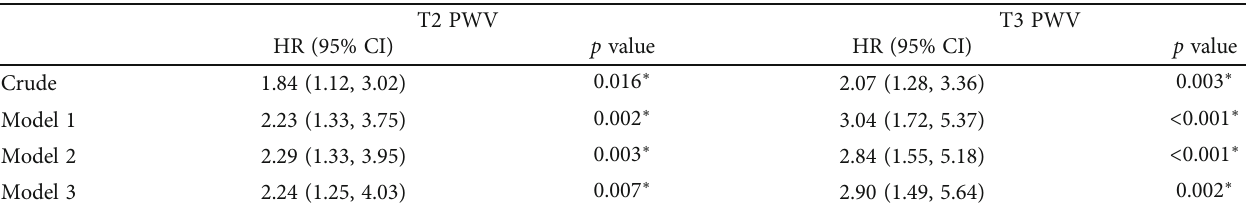
Figure 2: The relationships between baPWV and new onset/progression of DR: (a) boxplots showing distributions of baPWV between the group without and with new onset/progression of DR; (b) comparisons of the group with (dark orange) and without onset/progression of DR (light orange) based on the tertiles of baPWV were illustrated by stacked bar plots. Table 3: Independent association between degrees of baPWV and new onset/progression of DR revealed by Cox proportional-hazards regression